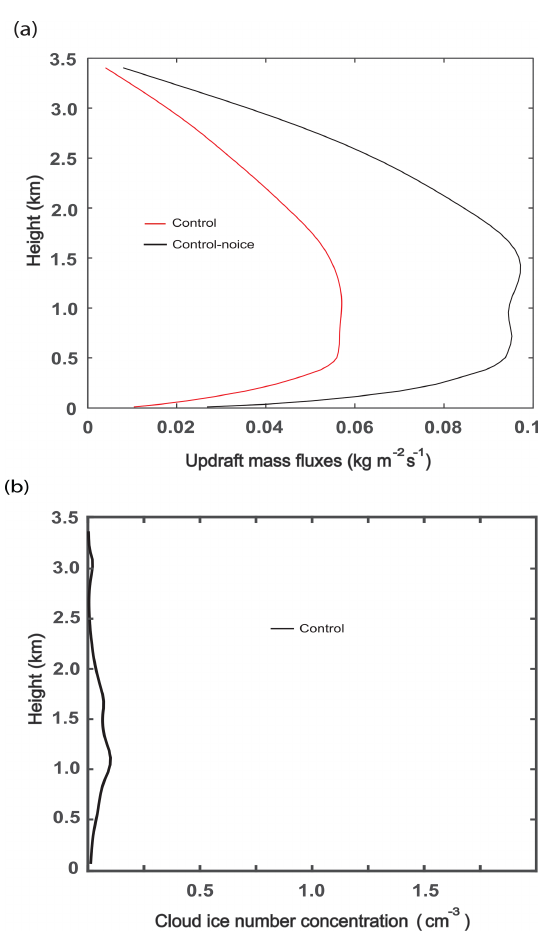
Figure 7. Cumulative frequency of (a) WP in the control run and LWP, which is WP, in the control-noice run and (b) LWP and IWP in the control run and LWP in the control-noice run at the last time step. low ∼ 200 g m − 2 in the control run. Particularly for IWP be- low ∼ 100 g m − 2 , the IWP frequency in the control run